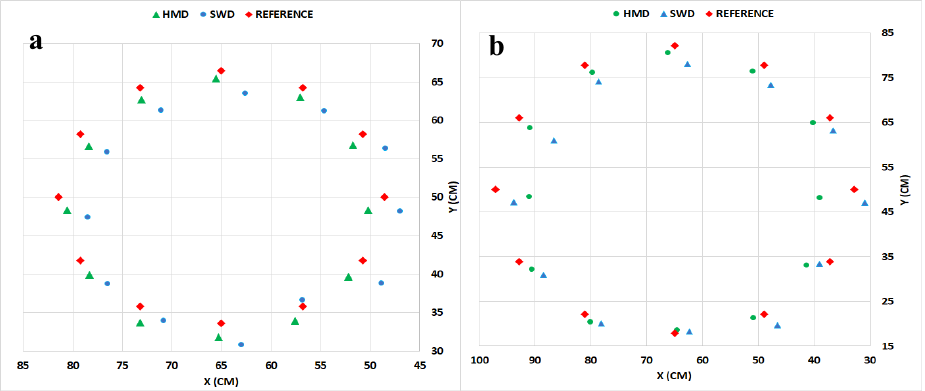
Figure 11. Average positions judgment with respect to actual (reference) target at a target distance of 150 cm from the participants for the exocentric distances ( a ) D5 and ( b ) D6 that shows a comparison between HMD and SWD.